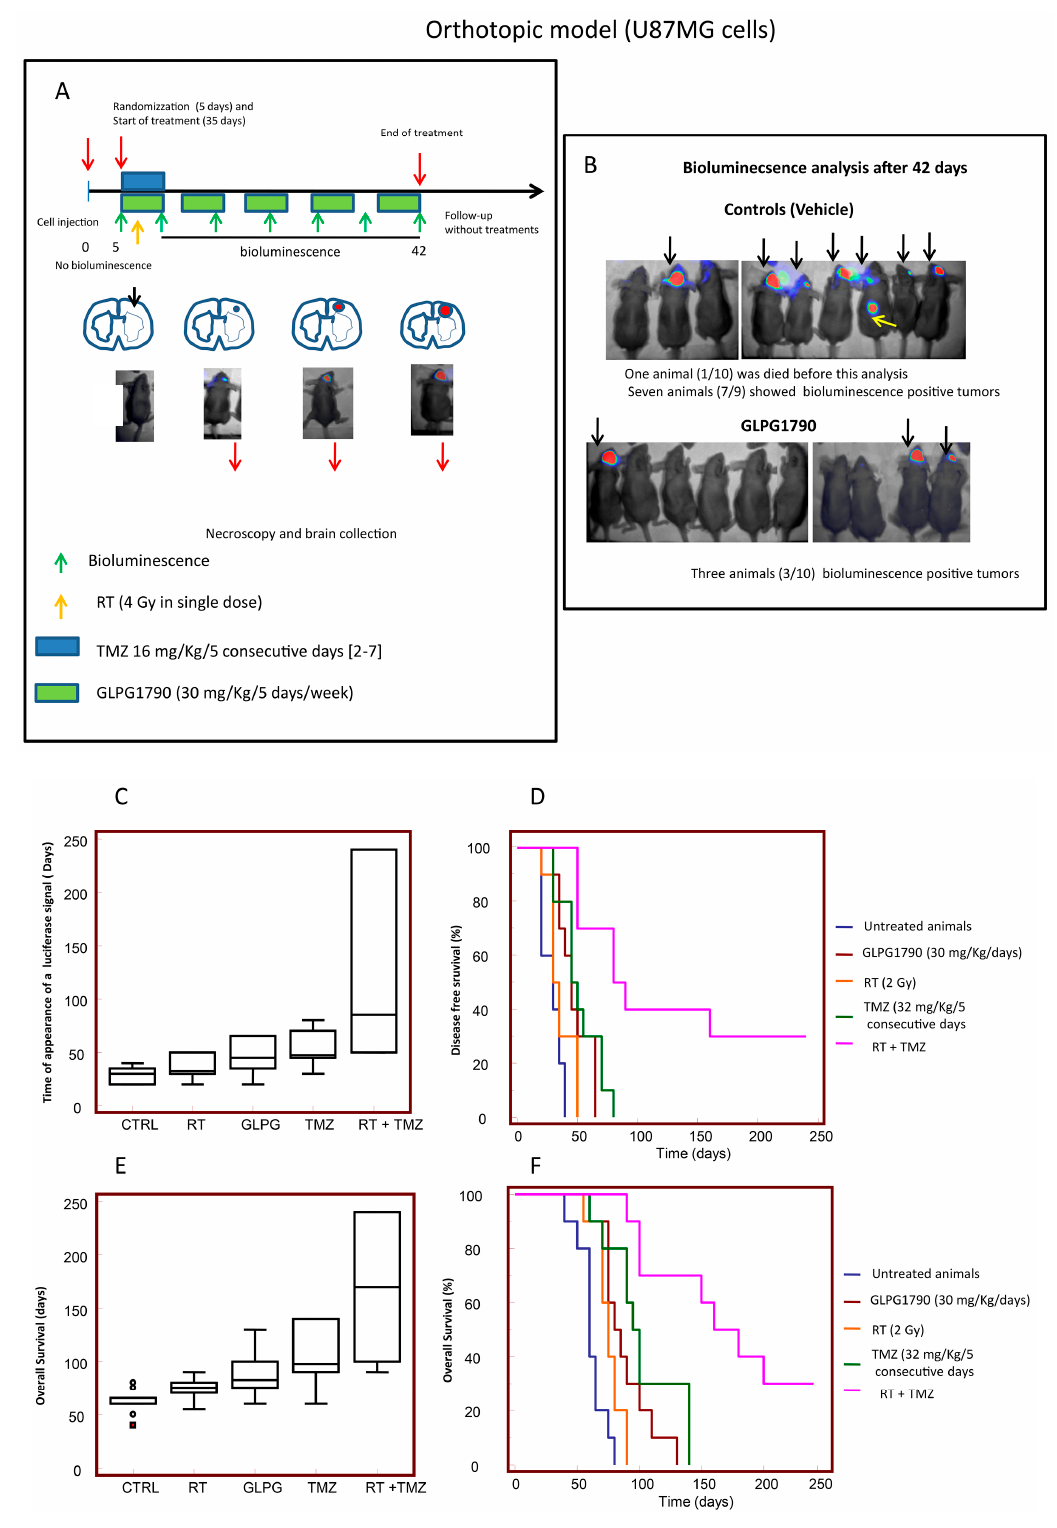
Figure 7. GLPG1790 increased Disease Free Survival (DFS) and Overall Survival (OS) in orthotopic intra-brain tumours using differentiated U87MG cells: a comparison with standard therapies. A small number of cells (3 × 10 3 ) were inoculated into the brain to simulate a chemo and radio therapy treatment made with tumours in recurrent phase after surgery. Such a low number of cells remaining in the operatory bed could re-grow and give rise to a recurrence. Five days after cell injection, when